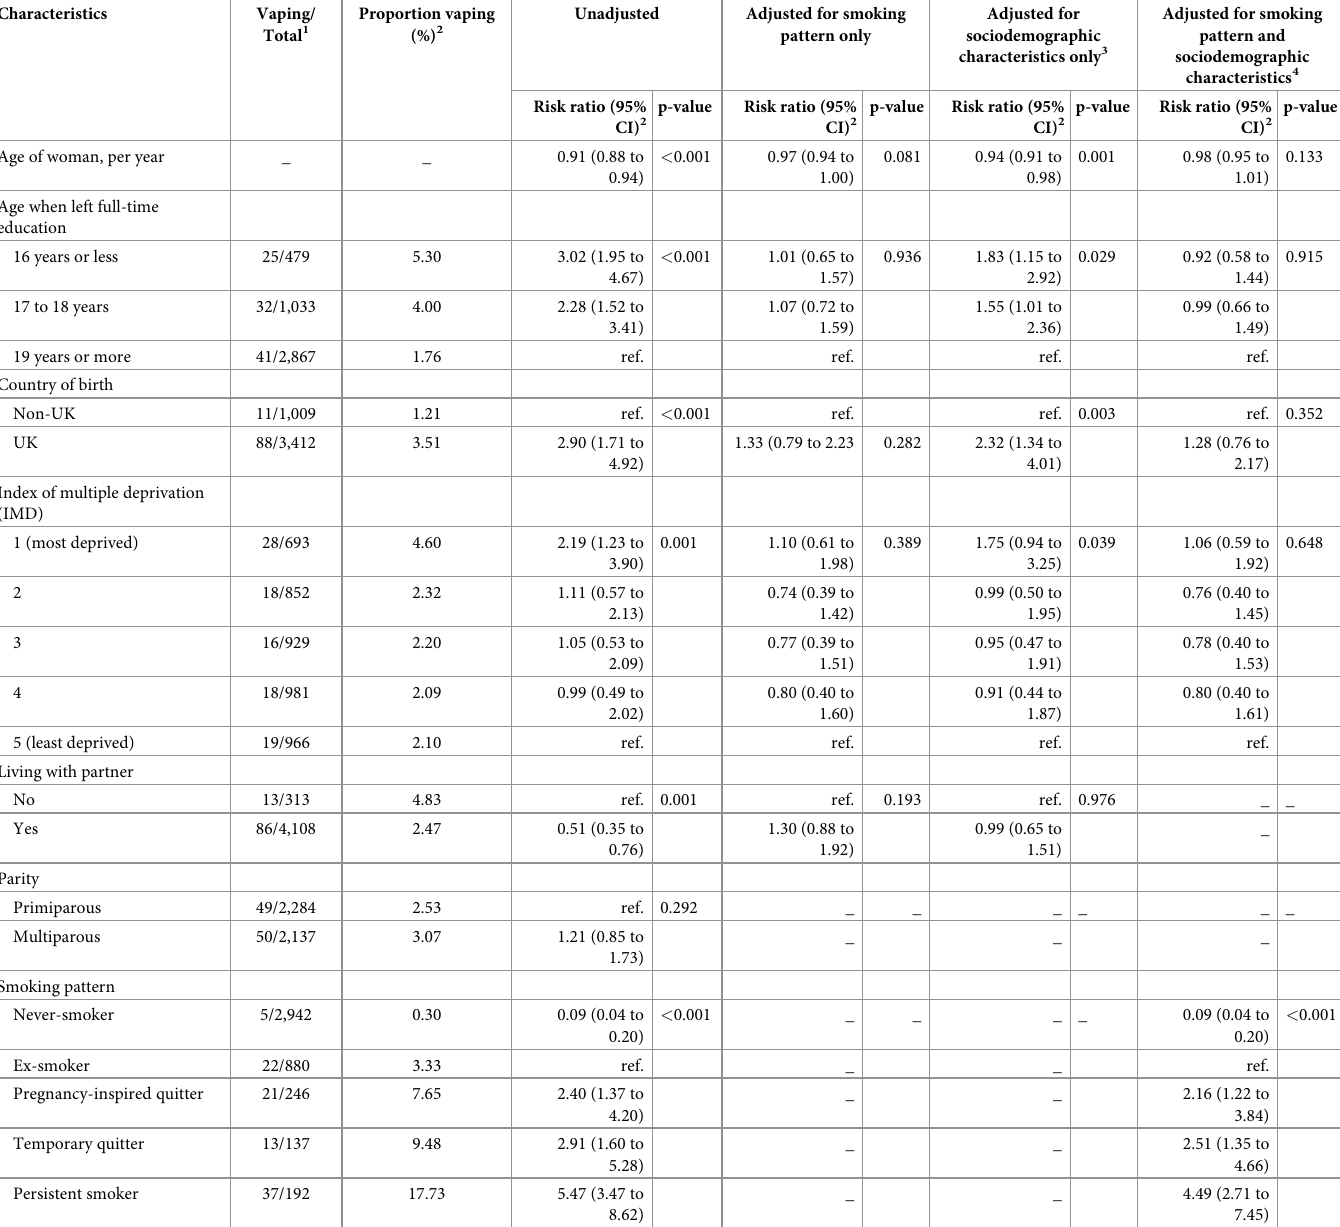
Table 2. Characteristics associated with vaping in pregnancy. Characteristics